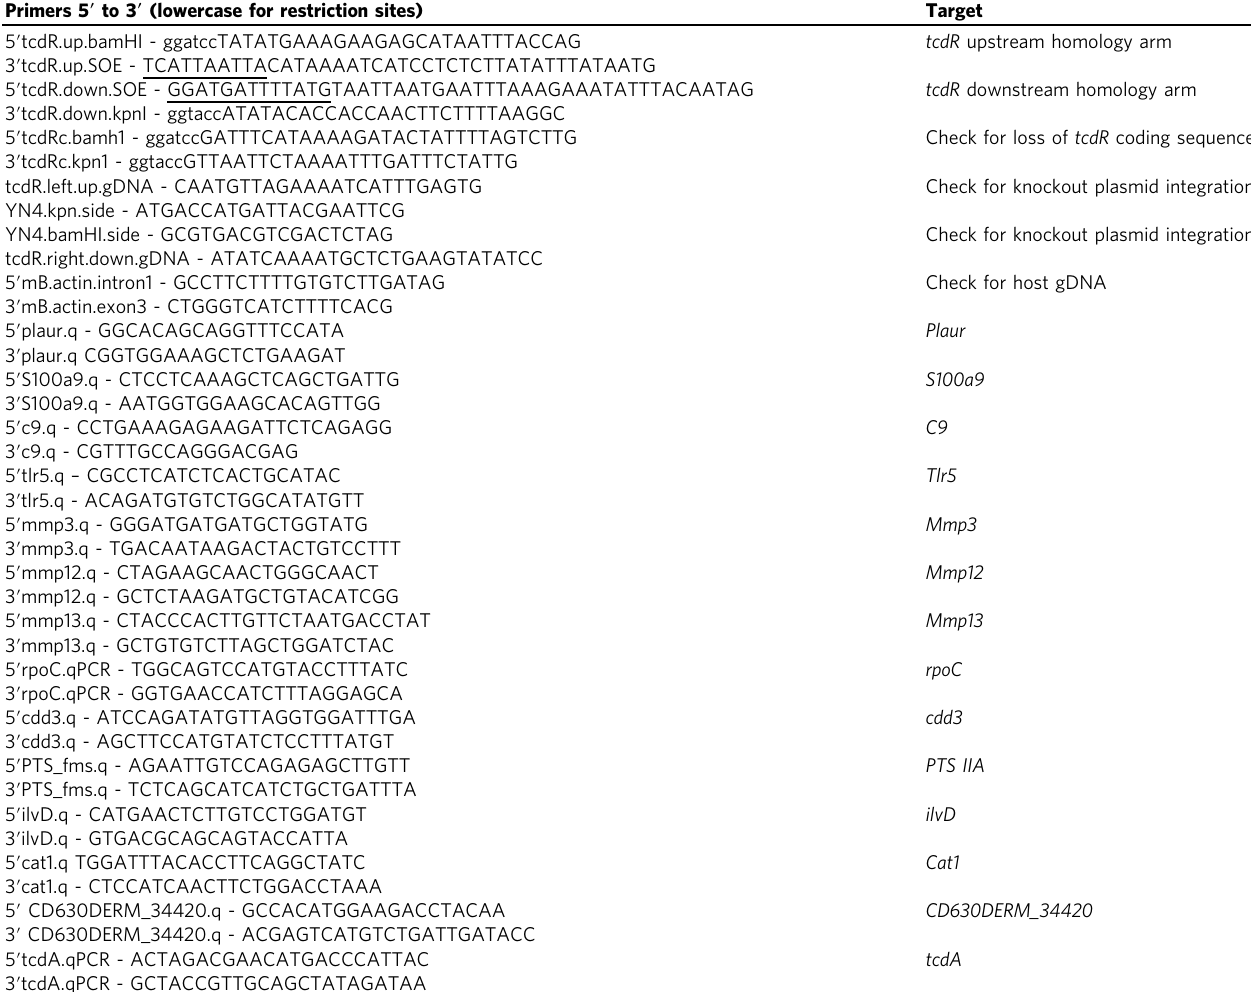
Table 1 Primers used in this